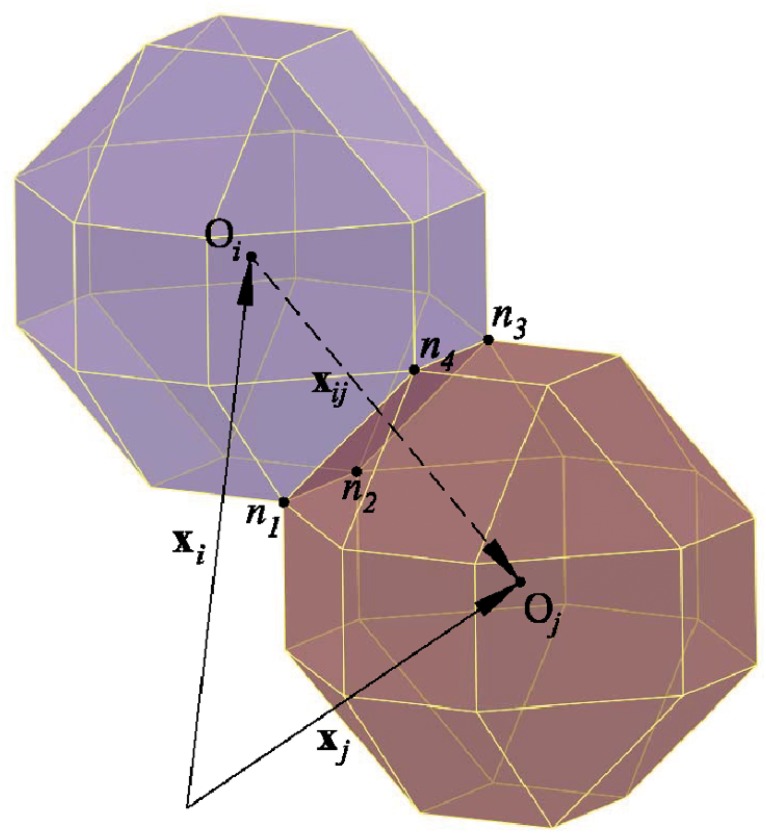
Interaction of two cells in contact.For the assumed cell configuration, two cells can have four common nodes (n
1:n
4). x
i and x
j are position vectors of the ith and the jth cells, respectively, while x
ij is a vector passing by the centroids of the ith and jth cells. The distance between their centroids (Oi and Oj) is equal to or greater than the proposed cell diameter, ‖x
ij‖ ≥ 2r.